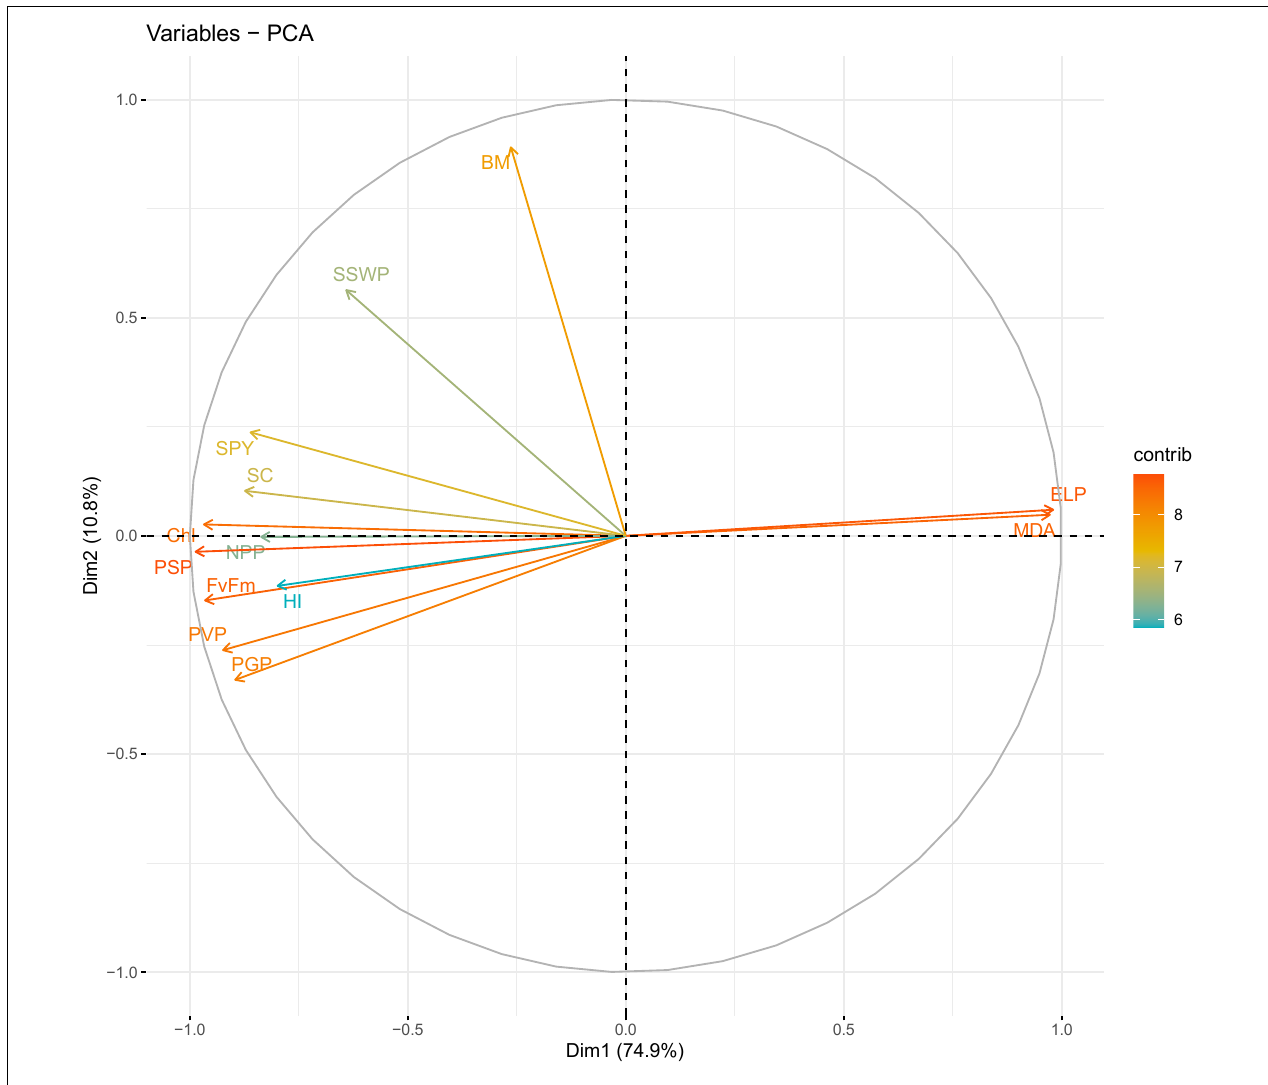
FIGURE 6 | Principal component analysis (PCA) of various traits in chickpea genotypes under heat stress in 2018–2019.